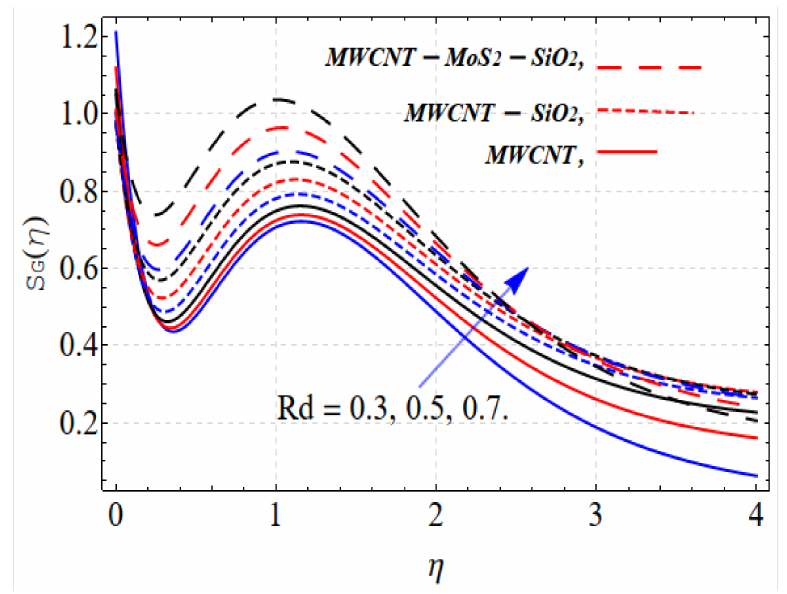
Figure 7. SG ( η ) vs. Rd .